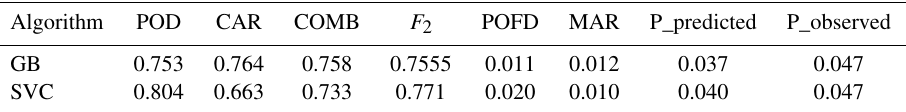
Table 4. Performance metrics for the proposed models using post-processed troposphere products and the full feature setup (as shown in Table 1).